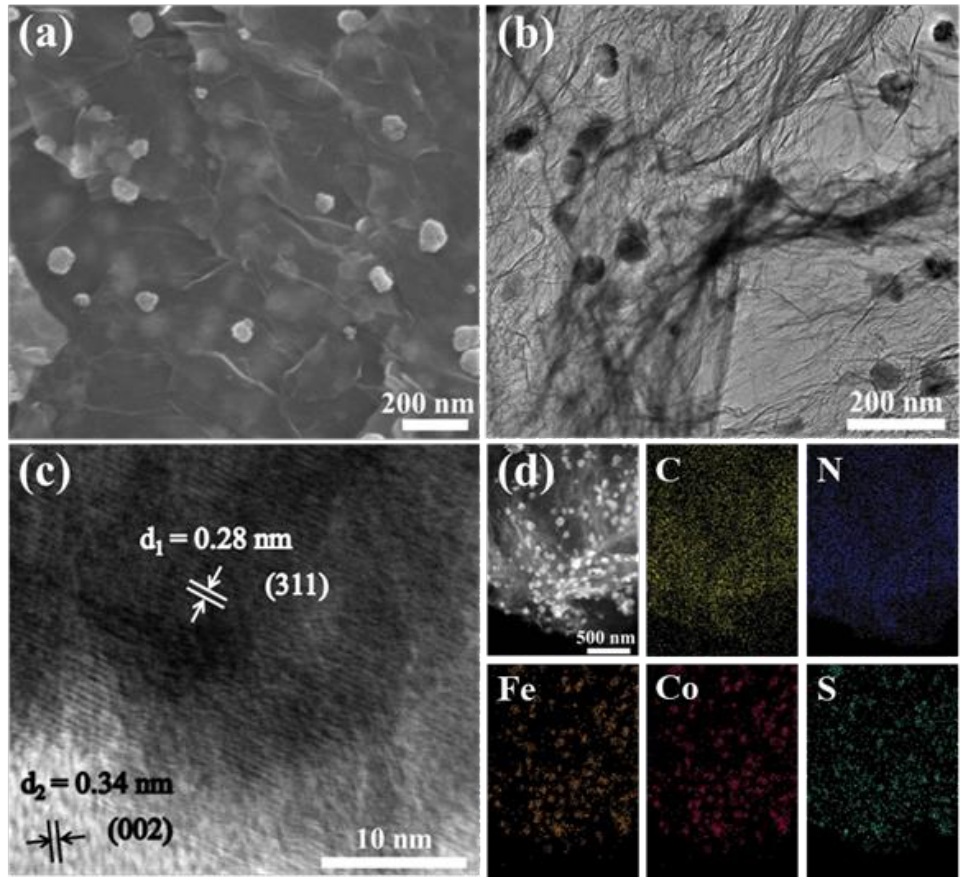
Figure 1. ( a ) SEM image of FeCo 2 S 4 /N-S-rGO; ( b ) TEM image of FeCo 2 S 4 /N-S-rGO; ( c ) HRTEM image of FeCo 2 S 4 /N-S-rGO; ( d ) corresponding EDS spectroscopy elemental mapping images of FeCo 2 S 4 /N-S-rGO.